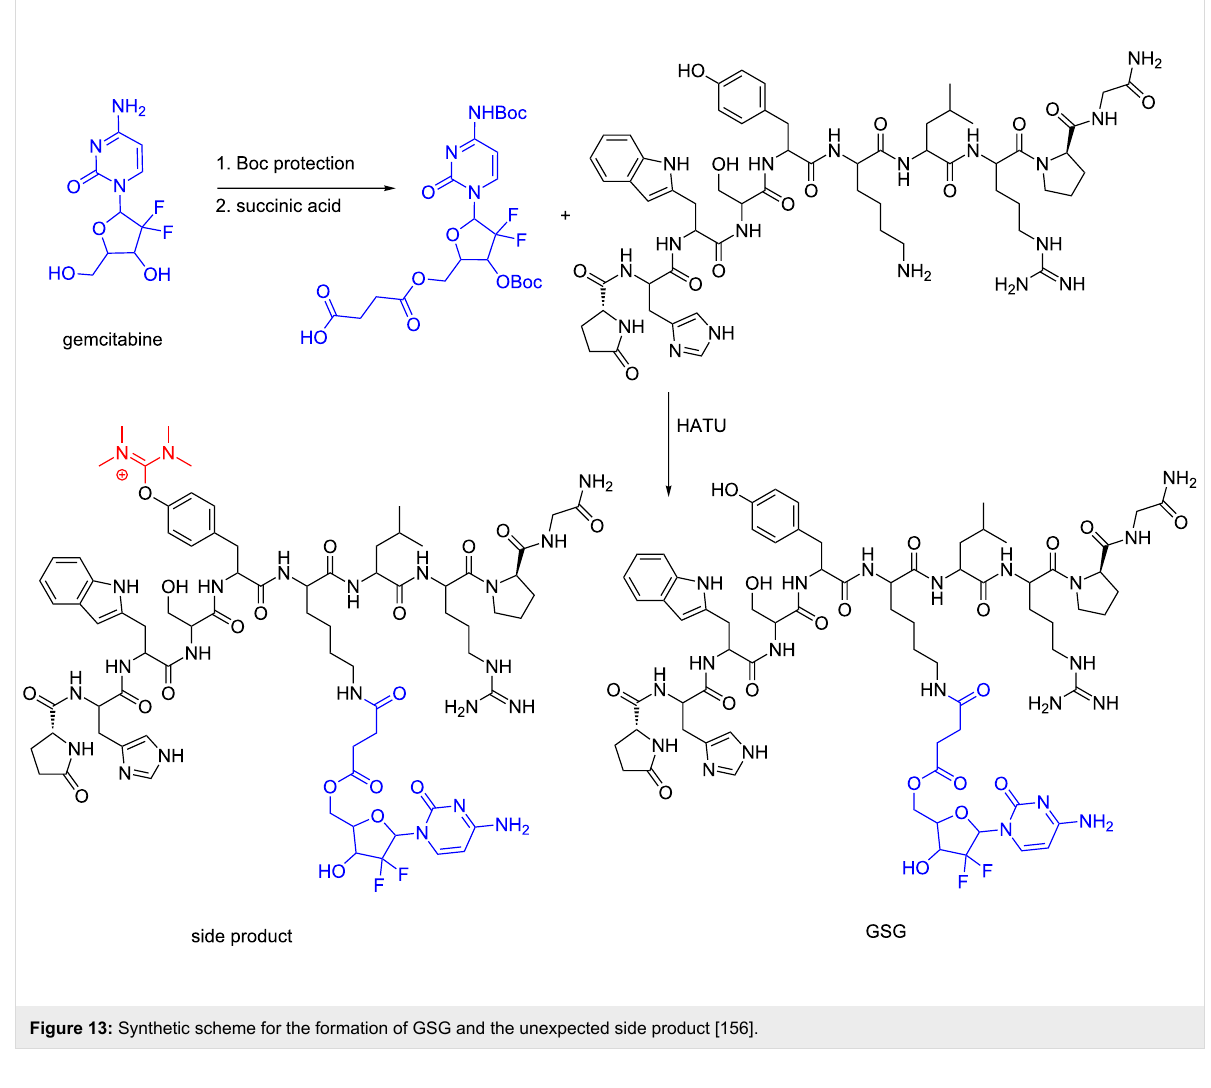
Figure 13: Synthetic scheme for the formation of GSG and the unexpected side product [156].